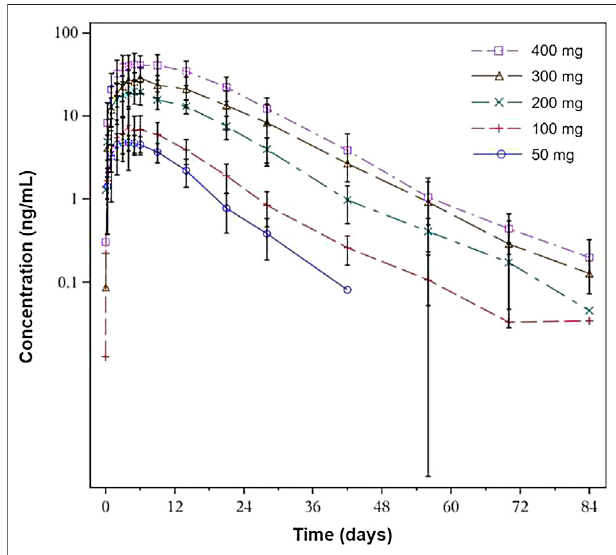
FIGURE 2 | Mean serum concentration-time pro fi les of